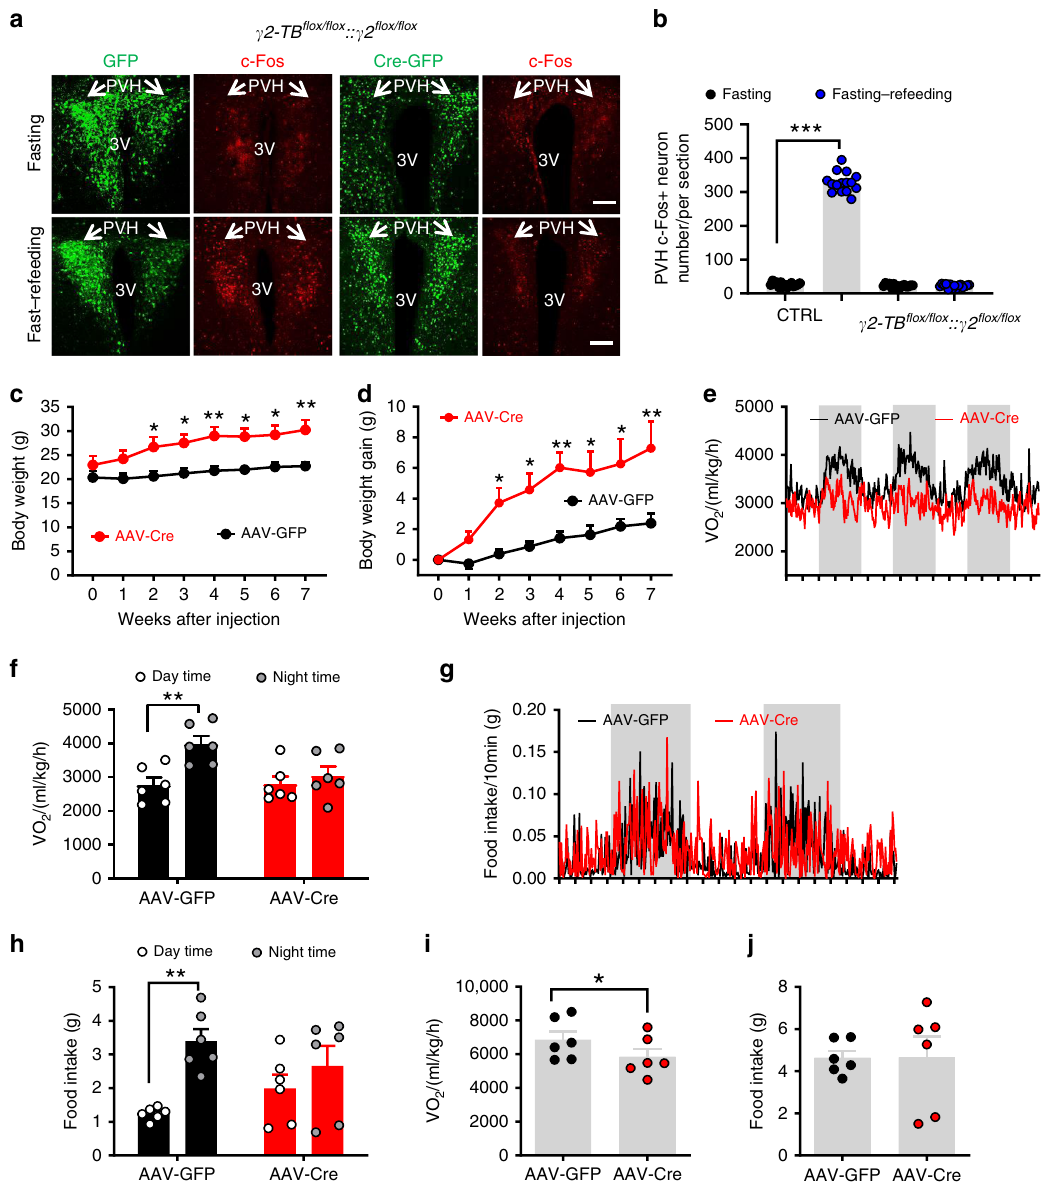
Fig. 6 Diurnal rhythms of GABA-A γ 2 subunit in the regulation of diurnal metabolism and body weight. a c-Fos expression pattern in response to overnight fasting or overnight fasting with 2 h refeeding in γ 2 fl ox/ fl ox :: γ 2-TB fl ox/ fl ox mice with PVH bilaterally injected with AAV-GFP (left panels) or AAV- Cre-GFP vectors (left panels). b Comparison of number of c-Fos-positive neurons in the PVH between fast and fast – refeeding in GFP- and Cre-injected mice (two-way ANOVA, n = 15/each, F (3, 56) = 1438, *** p < 0.0001, Control fasting vs fasting – refeeding; p = 0.9984, γ 2 fasting vs fasting – refeeding). Arrows point to the PVH proper. Littermate control or γ 2 fl ox/ fl ox :: γ 2-TB fl ox/ fl ox mice (8 – 10 weeks old, males) received injections of AAV-Cre-GFP to bilateral PVH and were used for body weight and feeding measurement using CLAMS. c , d Weekly body weight ( c , two-way ANOVA, n = 6 each, F (7, 80) = 2.682, ** p = 0.0063 for body weight at 7 weeks after injection between Control vs γ 2 mice) and weekly body weight gain ( d , two-way ANOVA, n = 6 each, F (7, 80) = 8.042, ** p = 0.0011, body weight at 7 weeks after injection between Control vs γ 2 mice) were followed. e , f Real-time energy expenditure O 2 consumption traces ( e ) and comparison in energy expenditure between day and night periods ( f , two-way ANOVA, n = 6 each, F (1, 20) = 3.541, ** p = 0.0097 GFP day vs night; p = 0.883 Cre day vs night). g , h Real time feeding traces ( g ) and comparison in feeding between day and night periods ( h , two- way ANOVA, n = 6 each, F (31, 20) = 3.380, ** p = 0.0062 GFP day vs night; p = 0.656, Cre day vs night). i , j Comparison of average daily O 2 consumption ( i , unpaired two-tailed Student ’ s t- test, n = 6 each, t = 2.231, d.f. = 10, * p = 0.0498) and food intake ( j , n = 6 each). All data are represented as mean ± SEM. Scale bar: 100 μ M. Shaded bars represent dark periods. Source data are provided as a Source Data fi